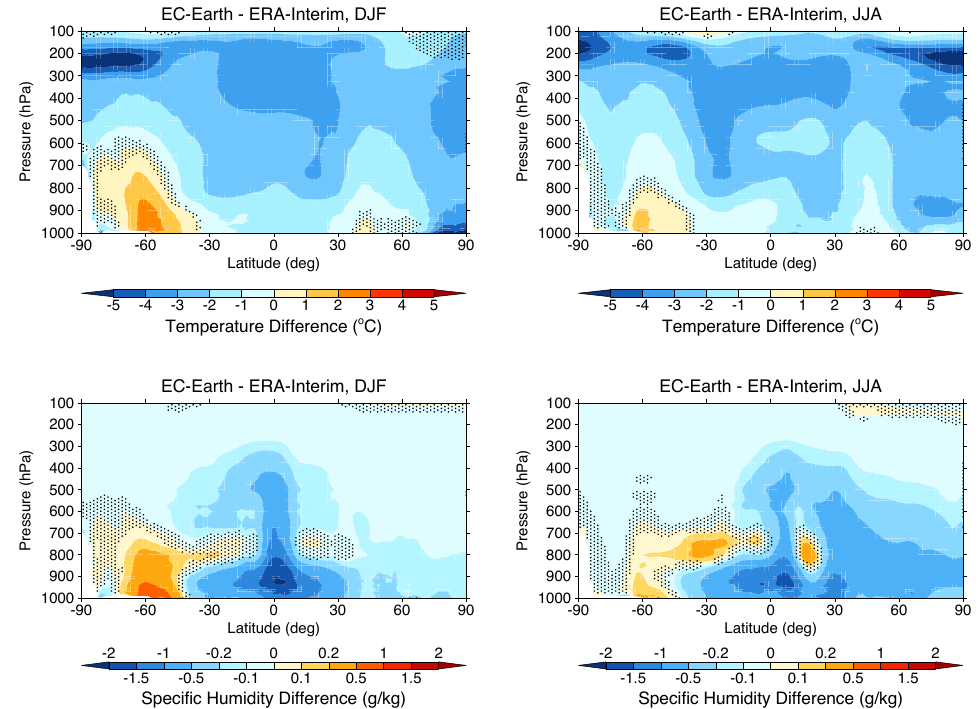
Figure 1. Zonal mean bias in temperature (top) and specific humidity (bottom) in EC-Earth compared to ERA-Interim for boreal win- ter (December–February, left) and boreal summer (June–August, right) for the period 2000–2009. Regions where the differences are not significant at the 5% level are indicated by the stippled